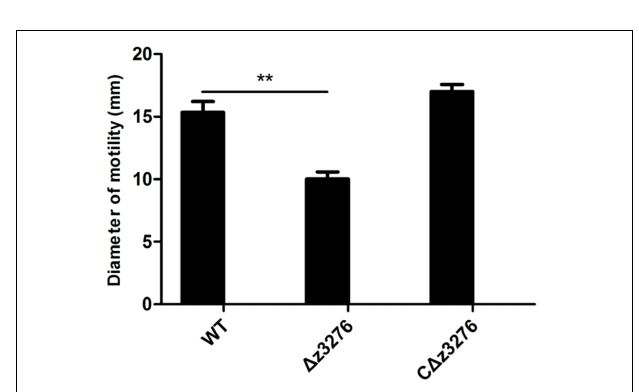
FIGURE 6 | (cid:49) z3276 showed shortened and lower fecal shedding in mice. Mice were orally challenged with strains WT, (cid:49) z3276 , c (cid:49) z3276 , or PBS. Fecal samples were collected on alternate days over a 2-week period. The CFUs in each sample were determined by plating onto SMAC plates at 37 ◦ C. The results shown are the averages of five mice per group.